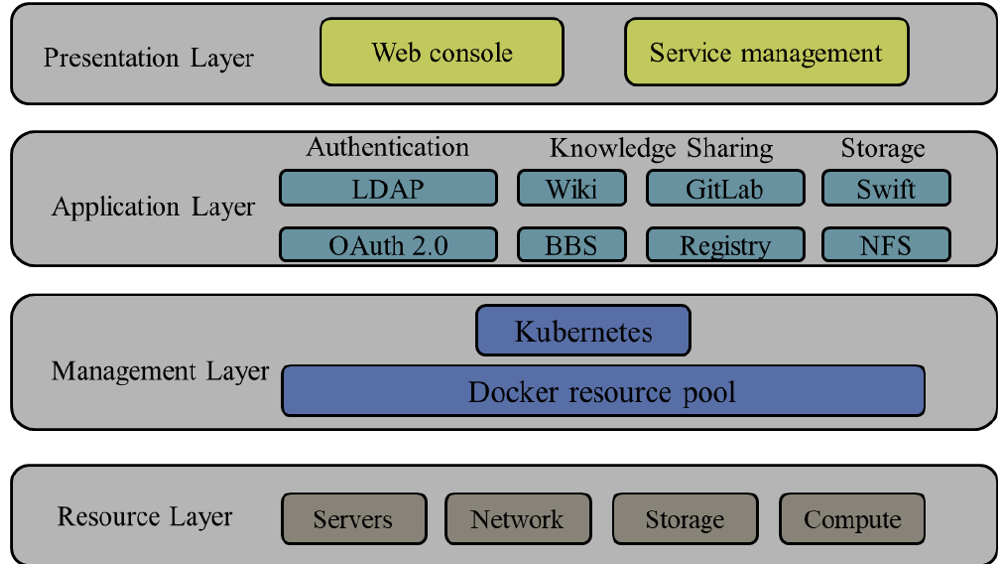
Figure 1. Architecture of the